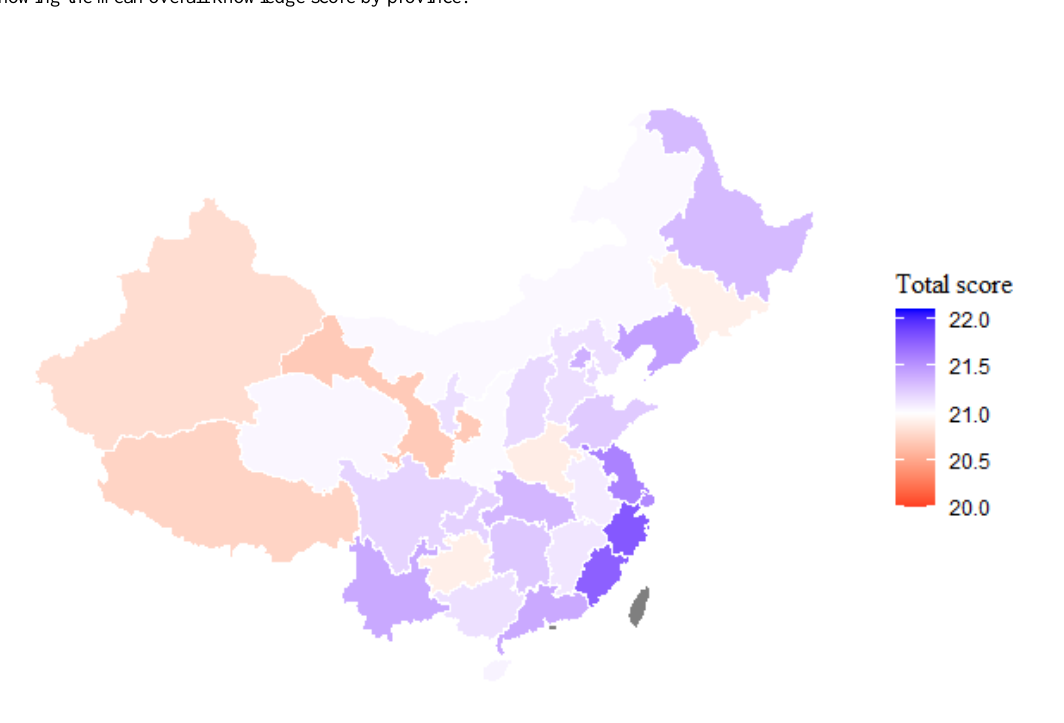
Figure 1. Map showing the mean overall knowledge score by province.